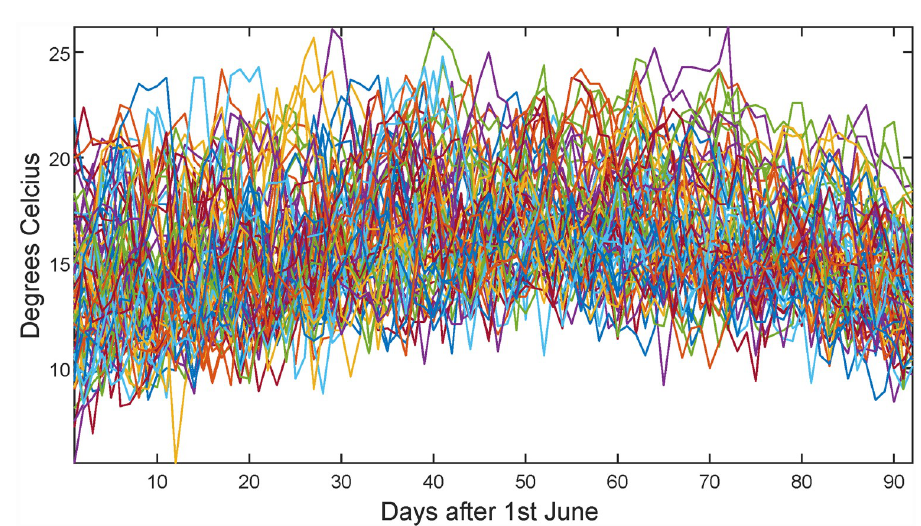
Fig 7. Daily mean temperatures at Oslo, Blindern, for the period 1937-2008.